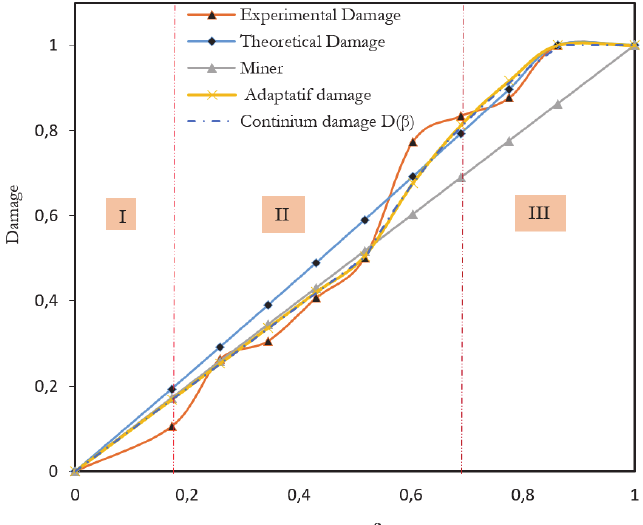
Figure 9: Approximate theoretical damage, through corrected Faupel, adaptive, continuum D ( β ) and experimental damages as a function of the life fraction.